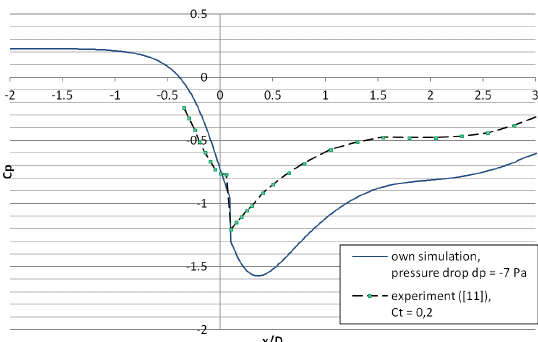
Figure 8. Abe and Ohya [11] reported that the c p drops from